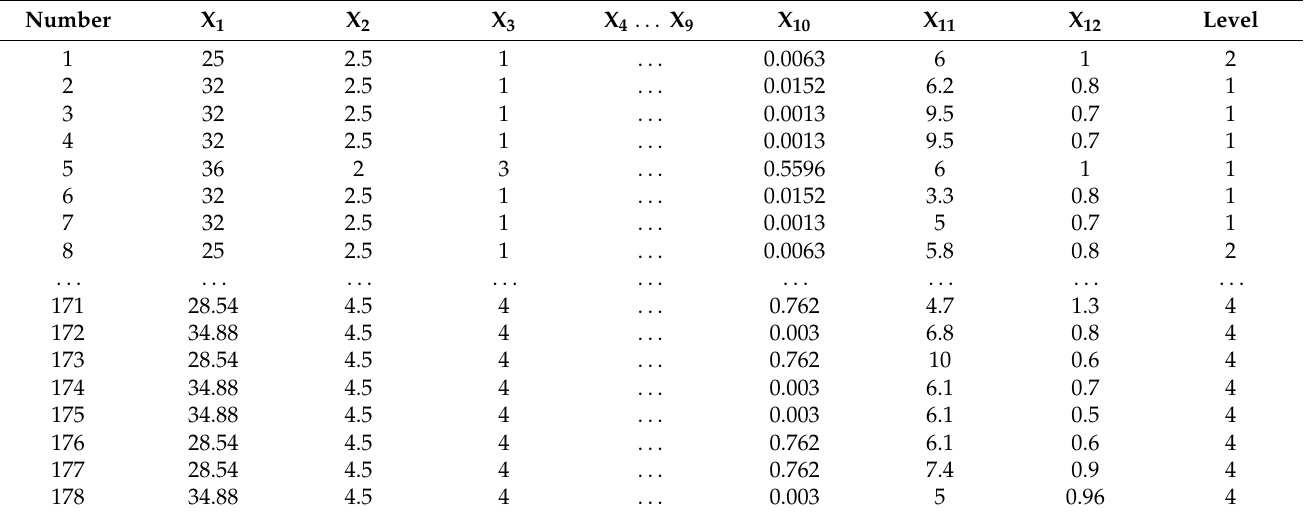
Table 1. Sample raw data of factors influencing coal–gas outburst in deep coal